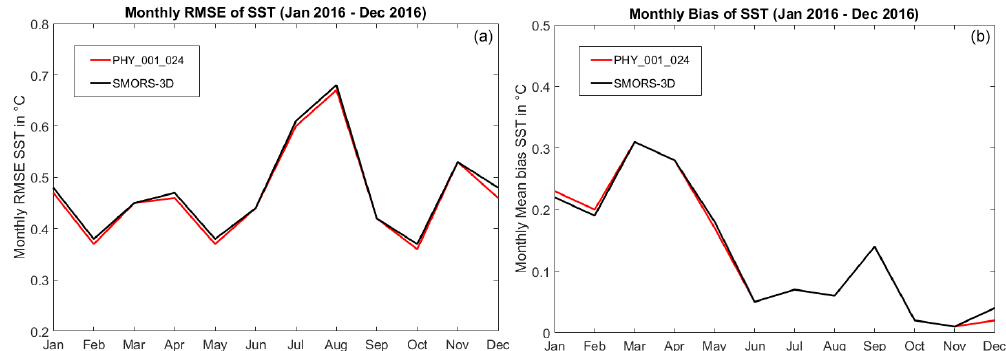
Figure 7. Monthly RMSE and bias comparisons: monthly RMSE (a) and monthly bias (b) between PHY_001_024 and OSTIA (red line) and between SMORS and OSTIA (black line).